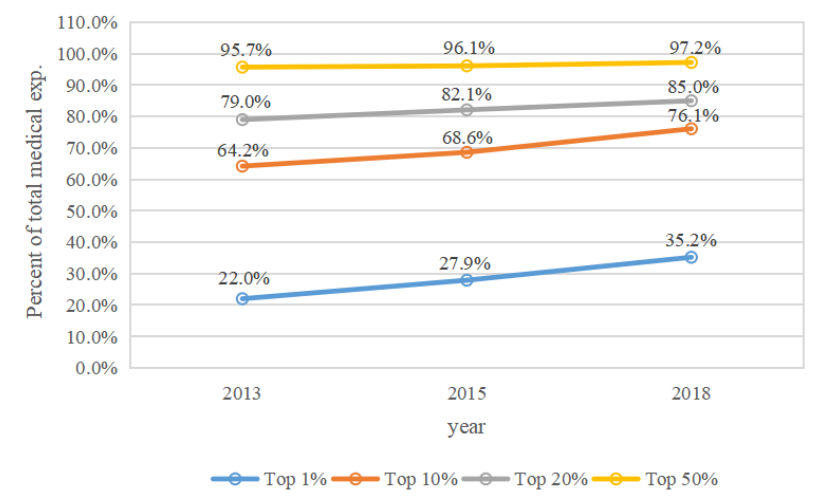
Figure 1. The concentration of total medical expenses by year.